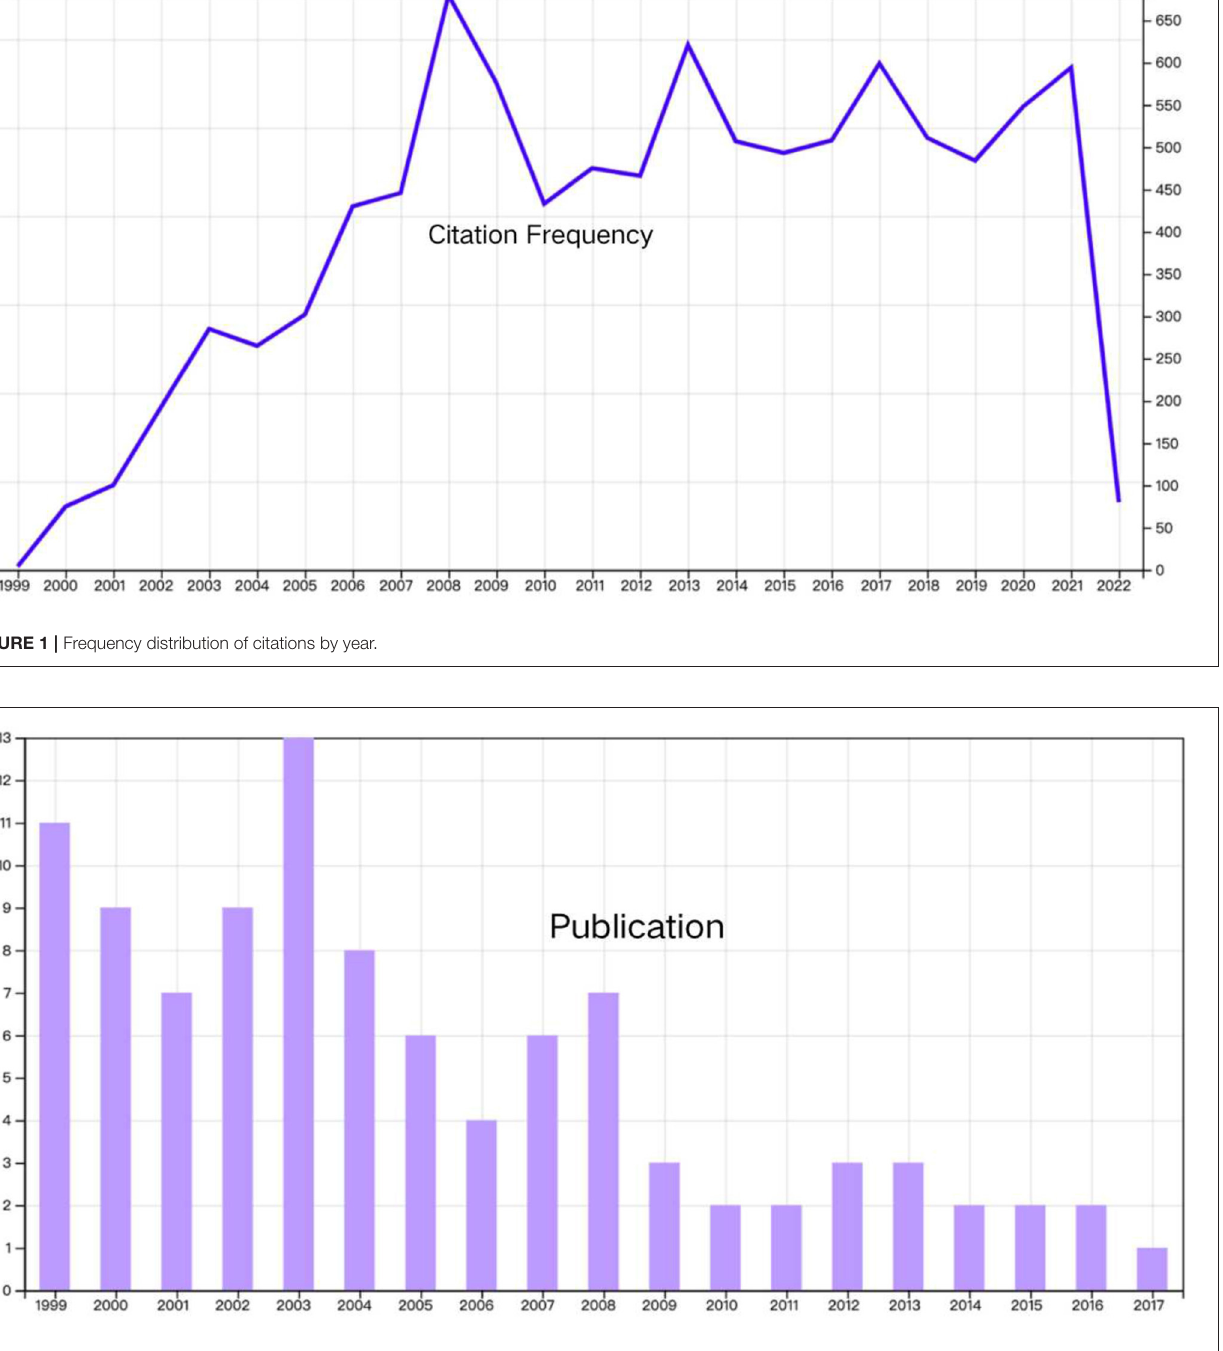
FIGURE 2 | Distribution of articles by year of